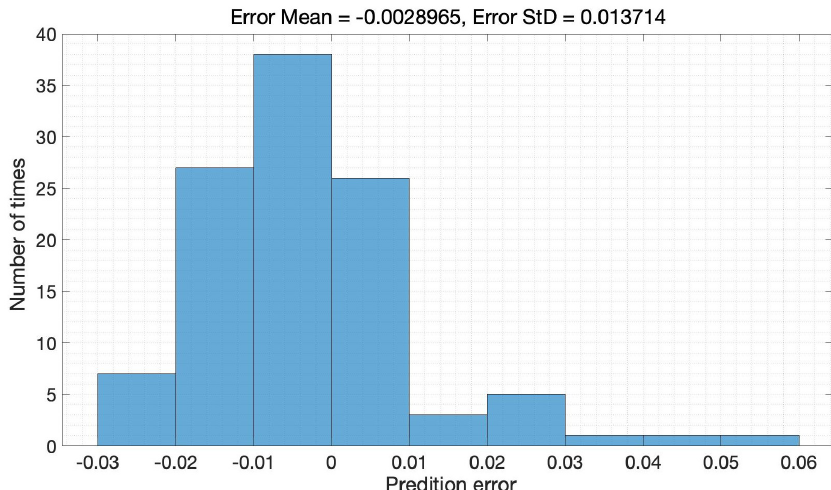
Figure 14. The error distribution